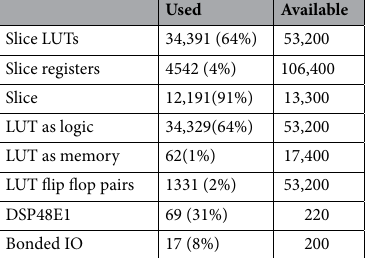
Table 2. Hardware utilization for the neuromorphic